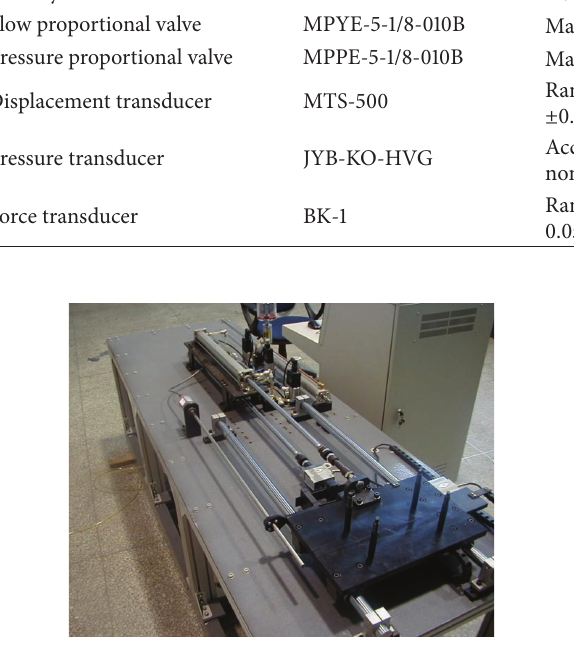
Figure 7: Experimental system.